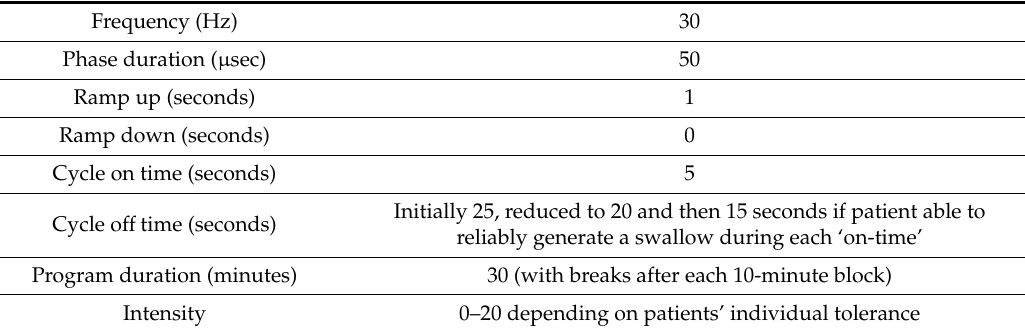
Table 1. Ampcare ESP TM neuromuscular electrical stimulation (NMES) stimulation parameters.